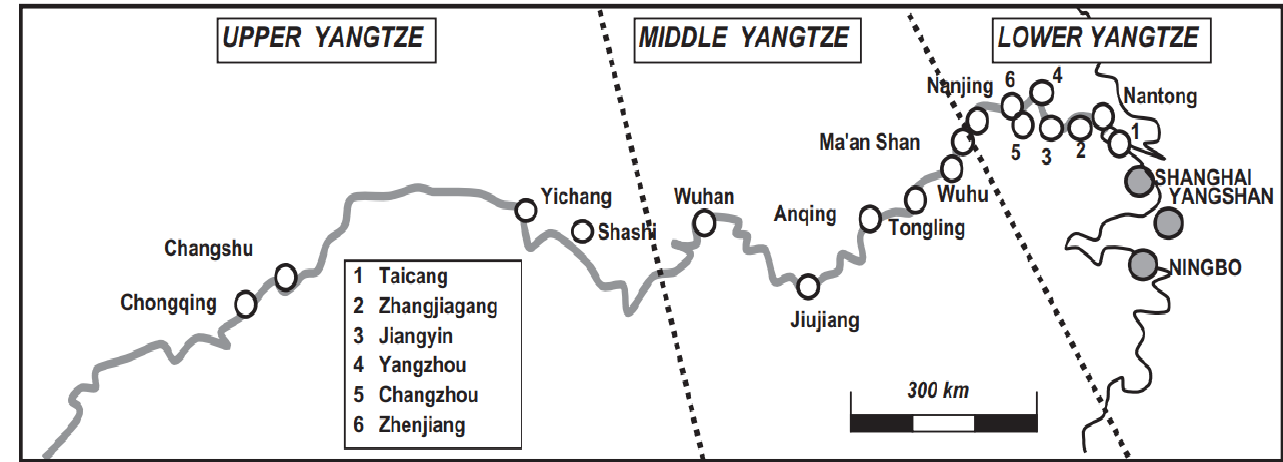
Figure 1. The channel of the Yangtze River.